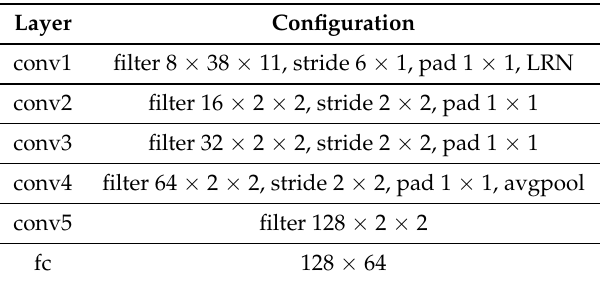
Table 1. The configurations of the CNN part.